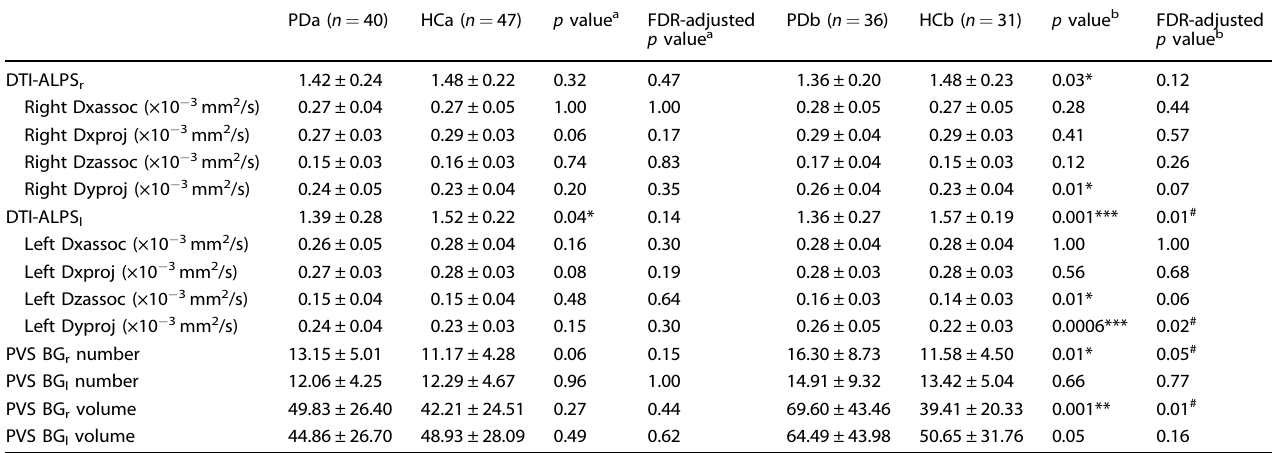
Table 2. Biomarkers of the glymphatic system in the subgroups of